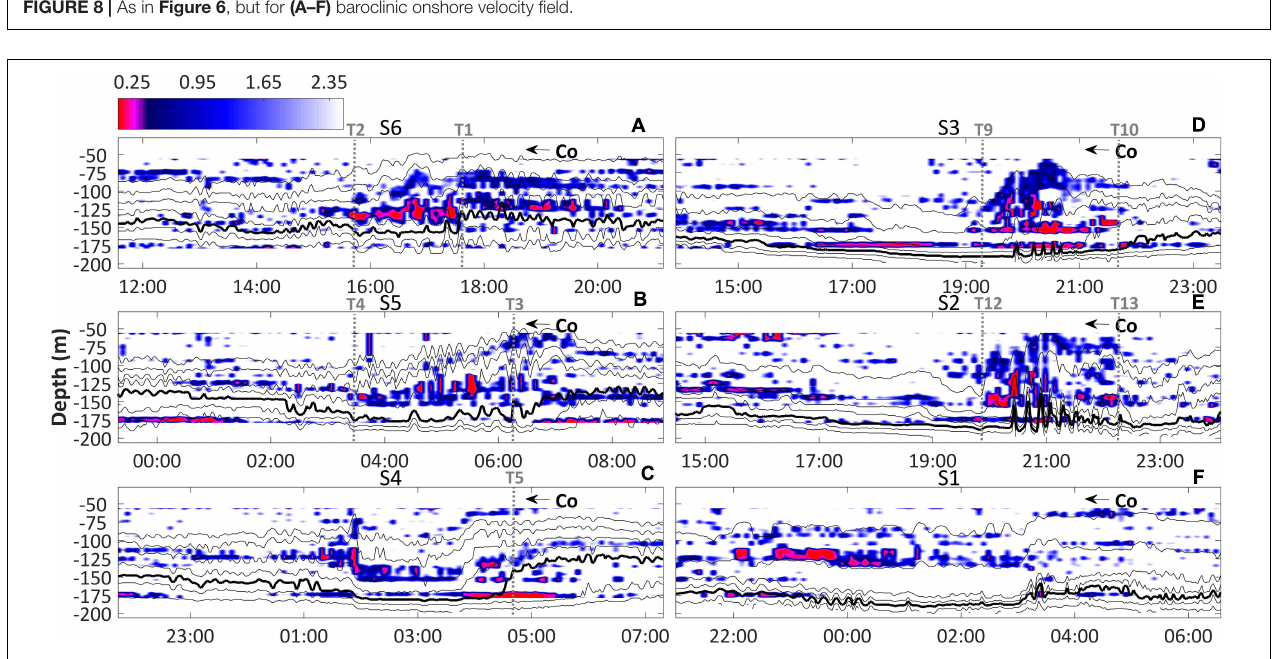
FIGURE 9 | As in Figure 6 , but for (A–F) non-dimensional Richardson number